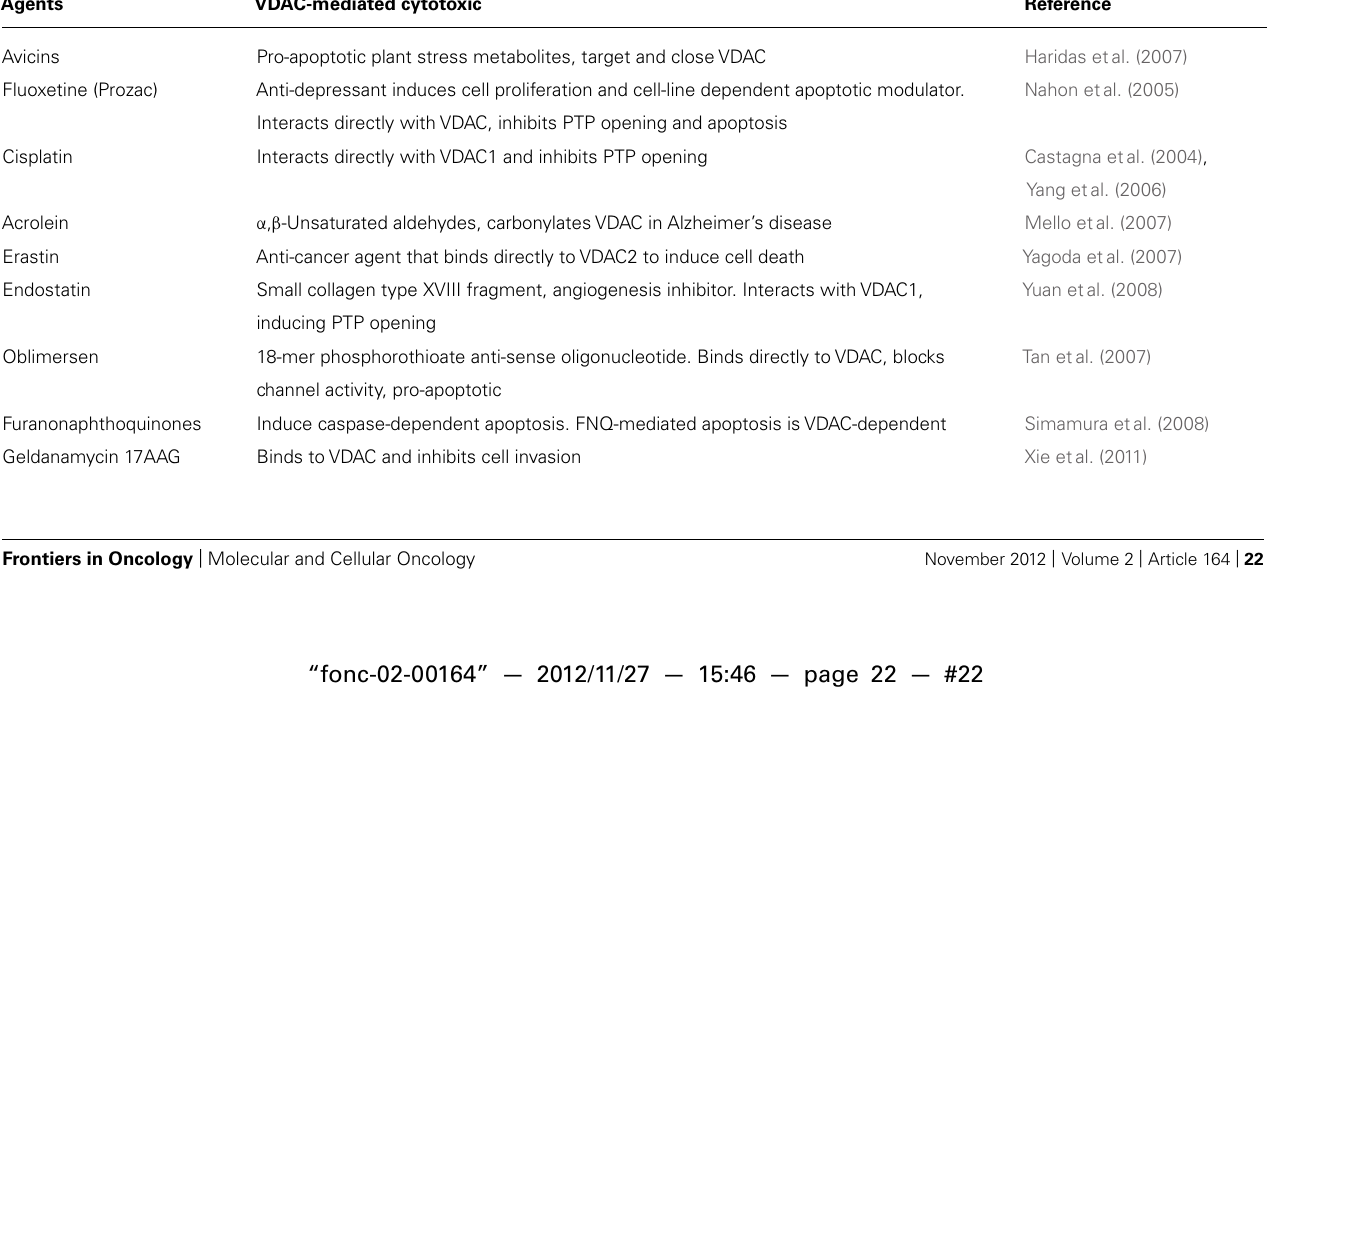
Table 2 | Reagents proposed to act viaVDAC (for details, seeVDAC as a PharmacologicalTarget for CompoundsAffecting Cell Proliferation or Apoptosis). Agents VDAC-mediated